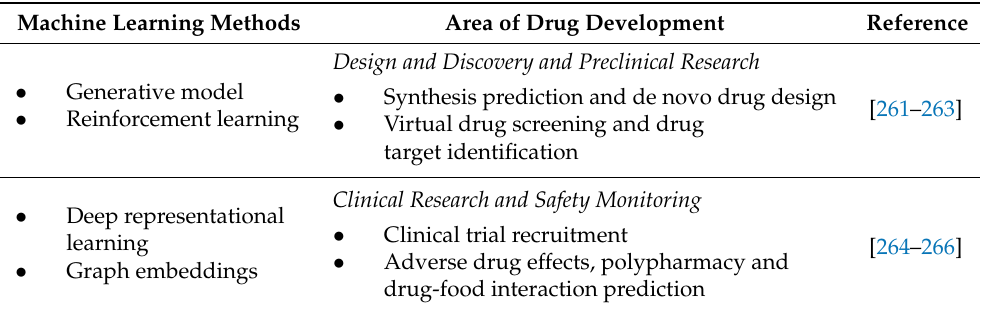
Table 4. Utility of machine learning methods in addressing the challenges of drug